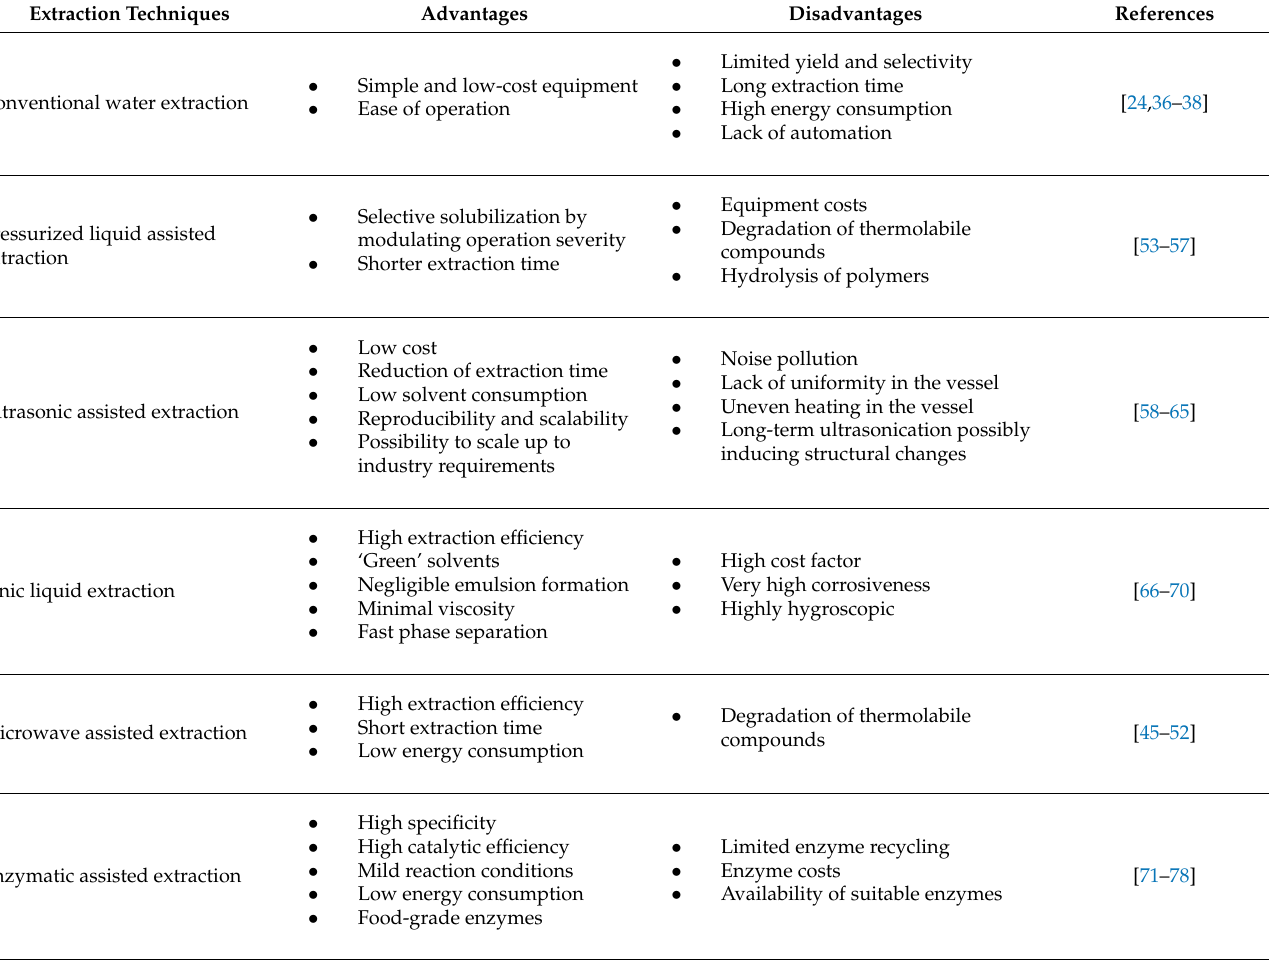
Table 1. Advantages and disadvantages of polysaccharide extraction